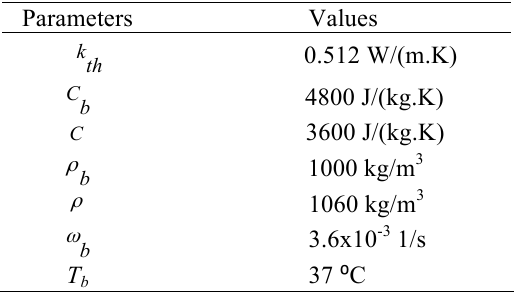
Table 3: Tissue thermal